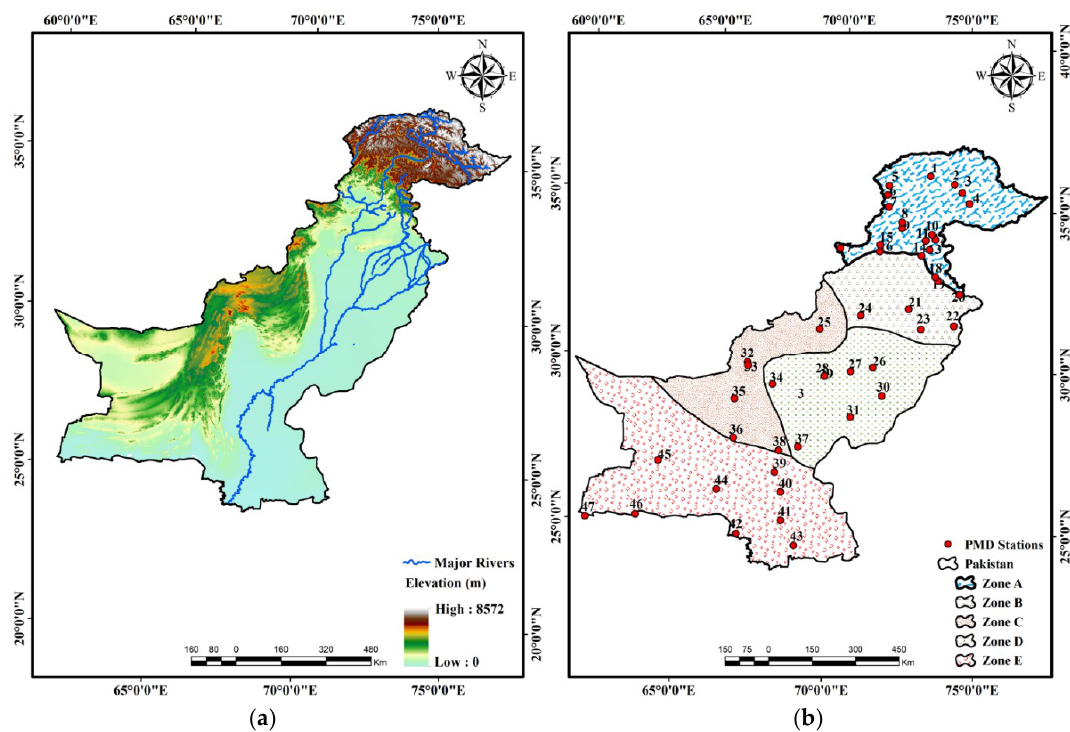
Figure 1. ( a ) Elevation and major rivers of Pakistan. ( b ) Five climate zones of Pakistan and selected Pakistan Meteorological Department (PMD) surface precipitation gauges (SPGs) (the SPG numbers and associated SPG names are shown in Table 1).